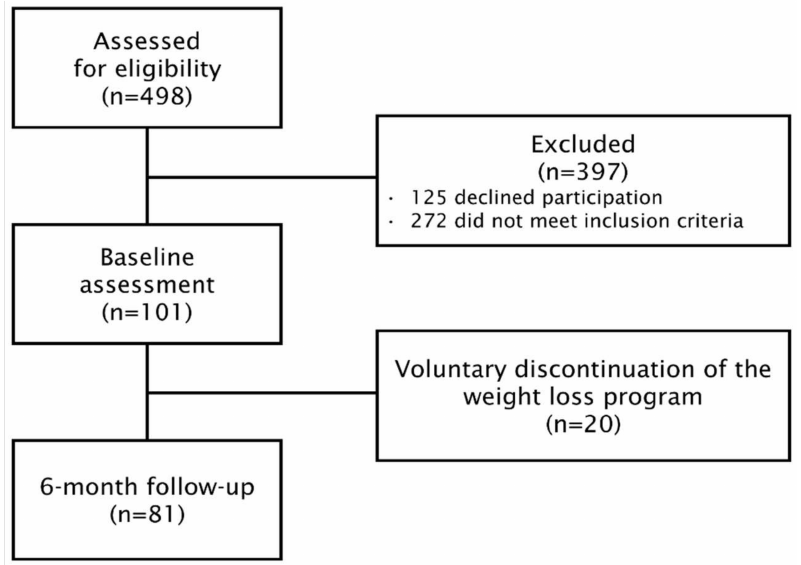
Figure 1. Flow chart of the study